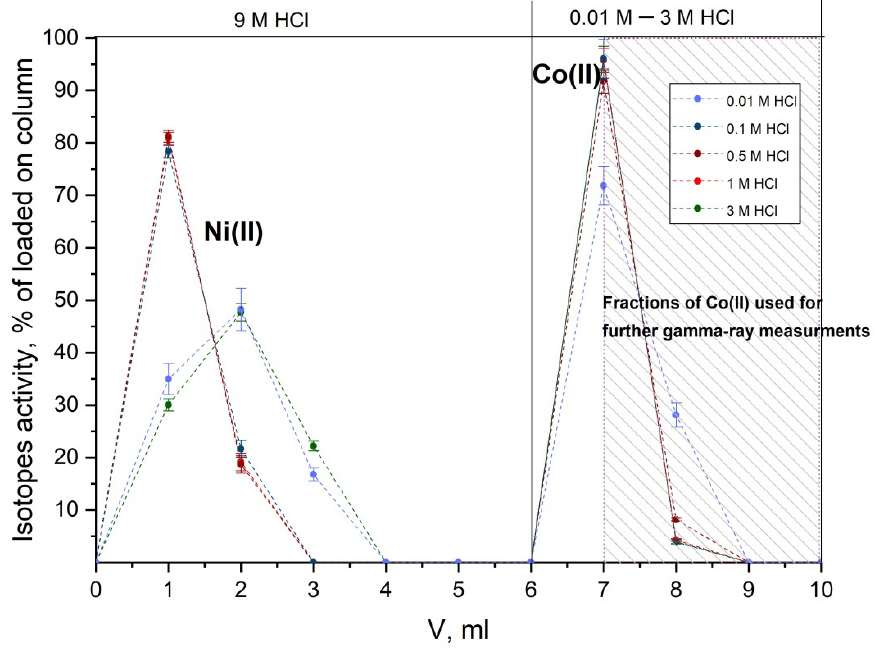
Figure 3. Elution curves of Ni(II) and Co(II) during separation on DGA resin column in HCl solu- tions .